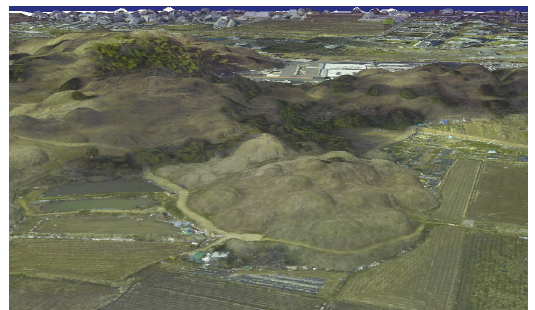
Fig17. Animation by Land-Viewer (OrthophotoImage+